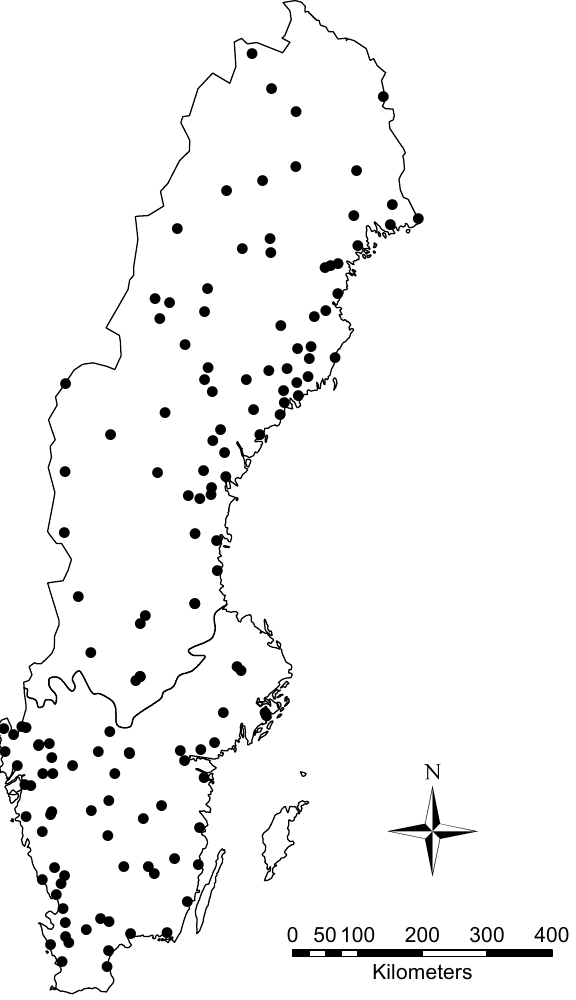
Fig. 1. All stream monitoring locations included in this study with the limes norrlandicus boundary separating the southern and north- ern regions.